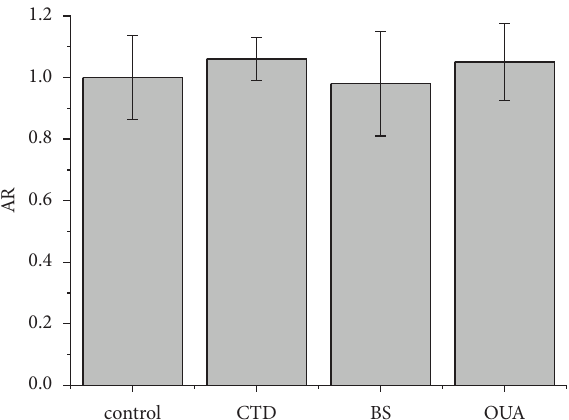
Figure 7: AR in A2780 cells treated for 1 h with 2 (10 μ M) in the absence (control) or in the presence of tetraethylammonium chloride (TEA, pretreatment, 20mg · mL − 1 ), or 1-methyl-4-phe- nylpyridin-1-ium (MPP + , cotreatment, 2mM), or cimetidine (CMT, cotreatment, 1.5mM). data are the mean ± SD of three independent replicates and were compared using one-way analysis of variance (ANOVA) with the Tukey post-hoc test. Statistical analysis (inhibitors vs. controls): no indication � not signifcant, ∗ p < 0.05, ∗∗∗ p <